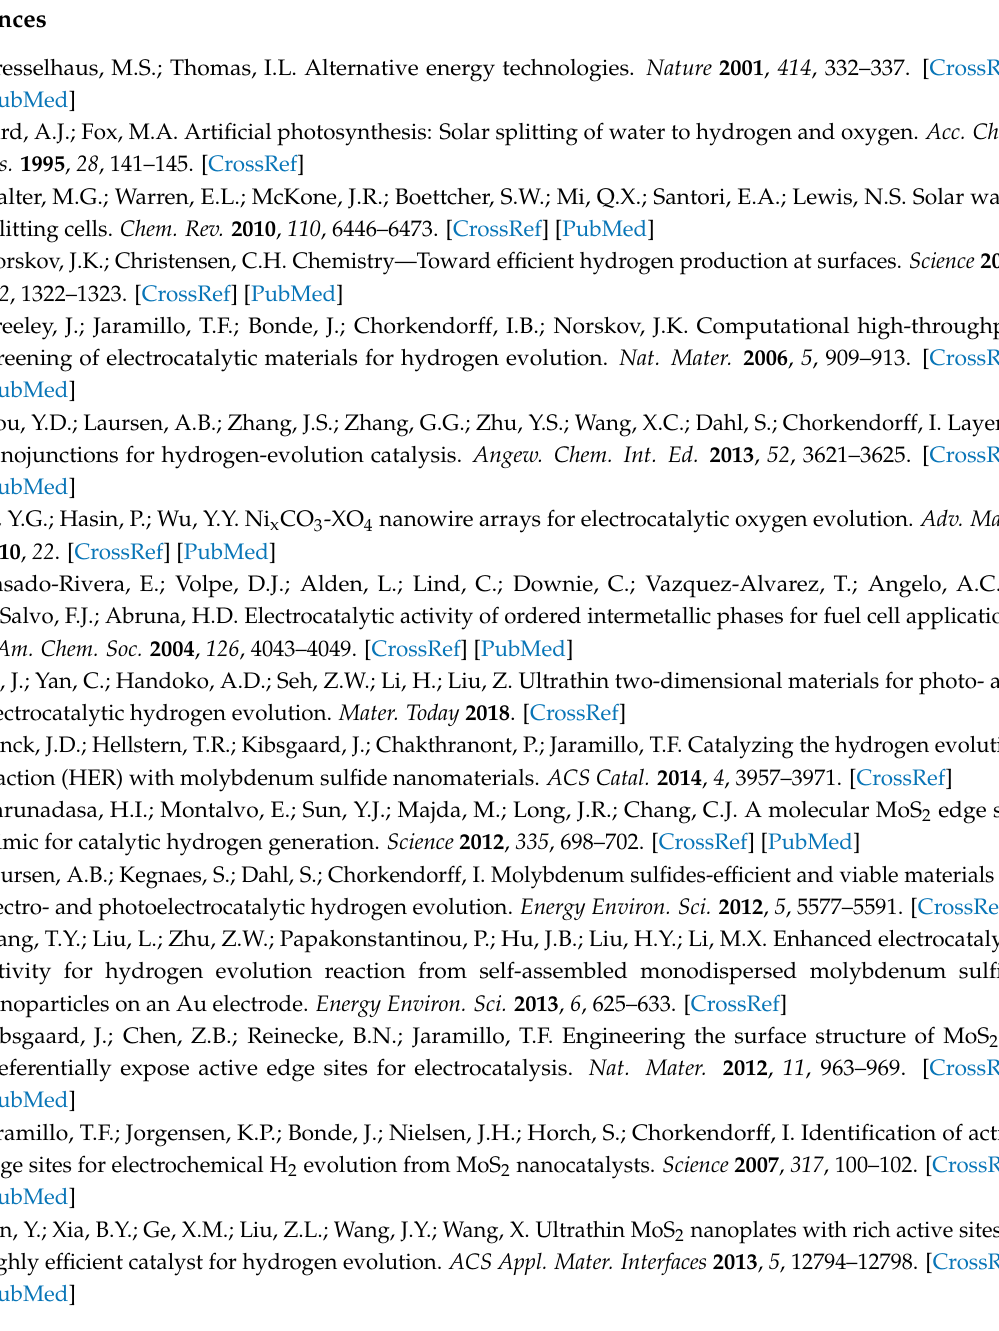
as a function of scan rates, Figure S6: Polarization curves of different ZT-MoS 2 : (a) ZT-MoS 2 -H, (b) ZT-MoS 2 and (c) ZT-MoS 2